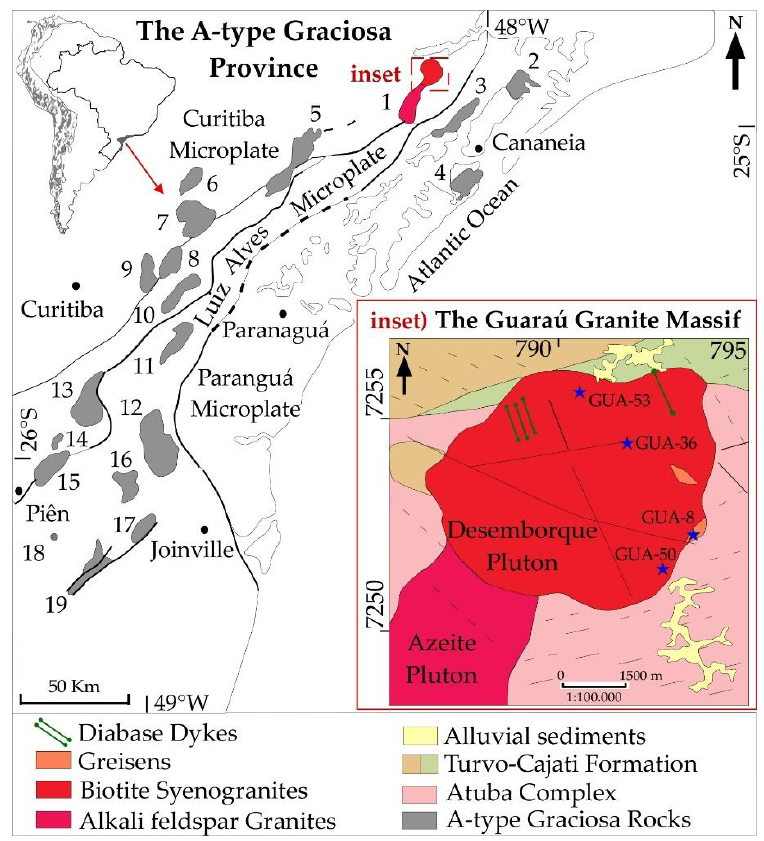
Figure 1. The location of the study area. The geological setting is of the Neoproterozoic A-type Graciosa province in S-SE Brazil (adapted from [26]). The A-type granites and syenites of the Graciosa Province are: ( 1 ) Guaraú Massif; ( 2 ) Serra do Paratiú/Cordeiro; ( 3 ) Mandira Massif; ( 4 ) Ilha do Cardoso; ( 5 ) Alto Turvo; ( 6 ) Capivari; ( 7 ) Ó rgãos; ( 8 ) Farinha Seca; ( 9 ) Anhangava; ( 10 ) Marumbi; ( 11 ) Serra da Igreja; ( 12 ) Morro Redondo Complex; ( 13 ) Palermo; ( 14 ) Agudos do Sul; ( 15 ) Rio Negro; ( 16 ) Dona Francisca; ( 17 ) Piraí; ( 18 ) Serra Alta; ( 19 ) Corupá; inset. A detailed geological map of the Guaraú Massif Granite, including the Desemborque and the Azeite plutons, is shown. The blue stars indicate the locations of columbite-bearing samples.